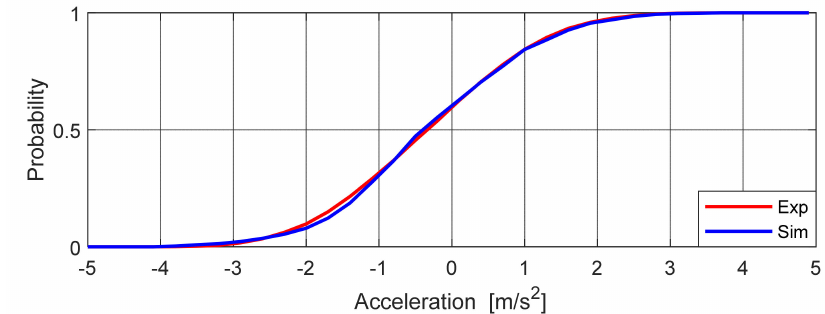
Figure 30. Distribution function, acceleration in vehicle CG. Table 5. Statistical characteristics of acceleration in vehicle CG.